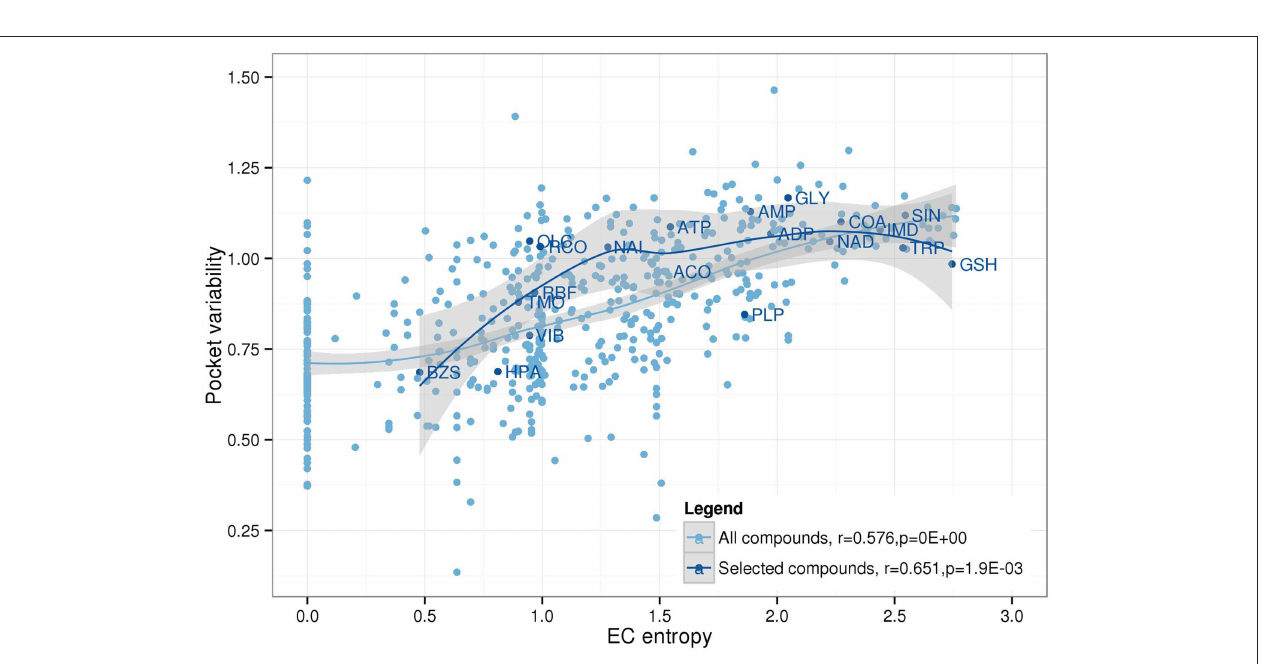
FIGURE 7 | Relationship between EC entropy and pocket variability. Linear Pearson correlation coefficients and associated p -values were calculated for all compounds (lightblue) and the 20 selected compounds (darkblue) as displayed in Figure 5 . Loess function was used to smooth the distribution (lines) including a 95% confidence region